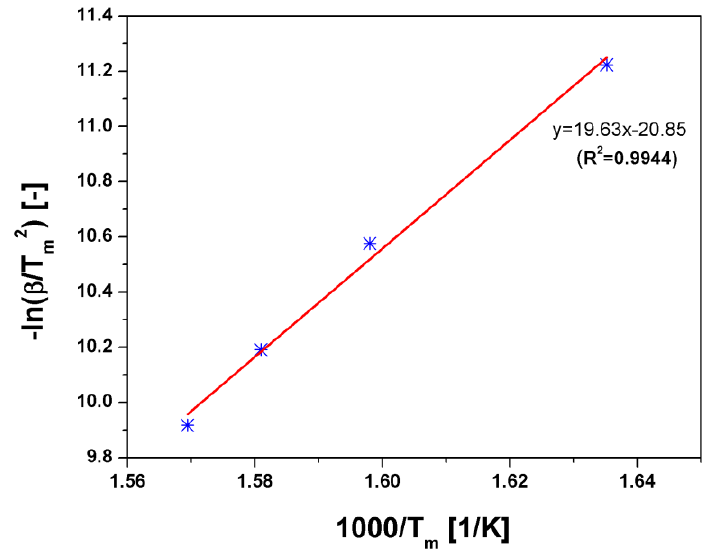
Table 3. Required time for accelerated aging calculated by the Arrhenius equation. Figure 4. Kissinger plot of the non-class 1E cable.